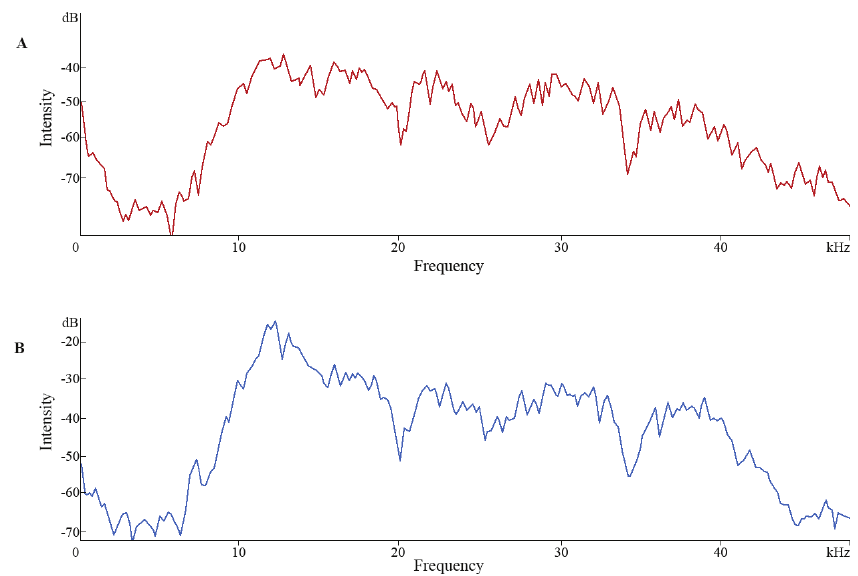
Figure 5. Parapholidoptera castaneoviridis male calling song spectrum: A opening hemisyllable frequen- cies (red) B closing hemisyllable frequencies (blue). Function: Hanning window; size: 512 (Romania, Ciucurova, 26°C).